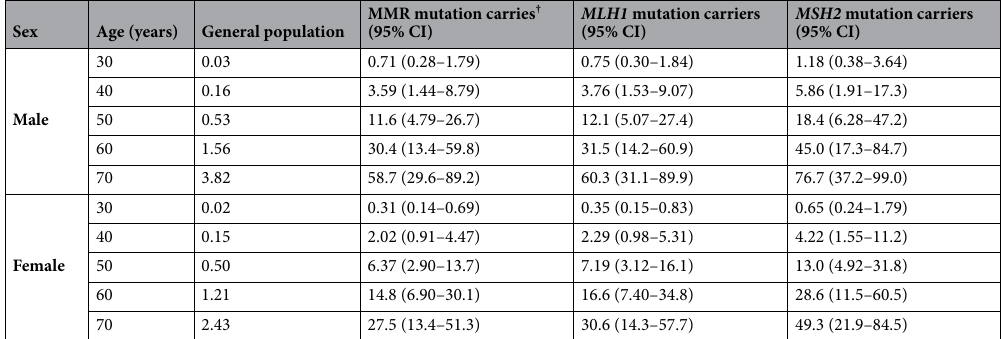
Table 3. Age- and sex-specific cumulative risk of colorectal cancer in the general population and patients with Lynch syndrome. MMR ; Mismatch repair genes. † Including MLH1 and MSH2.